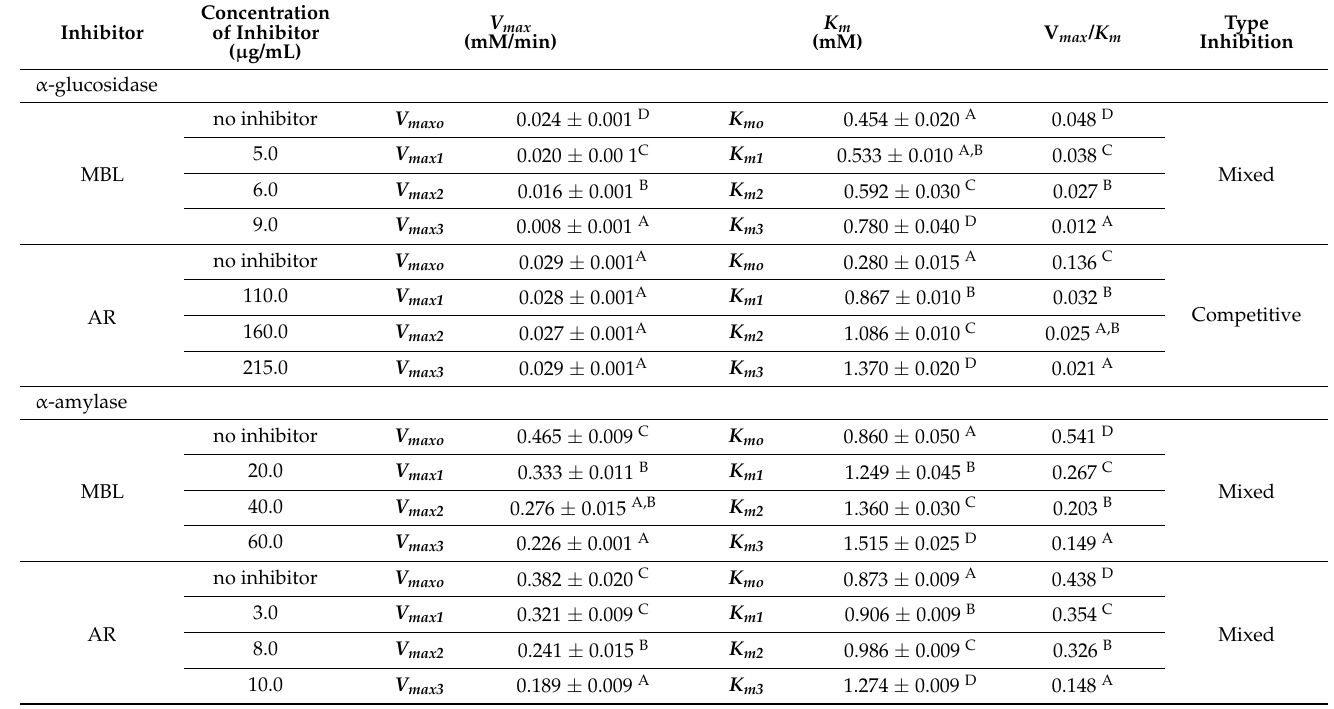
Table 3. Kinetic parameters of α -amylase and α -glucosidase in the presence of C. bullatus leaf extract and